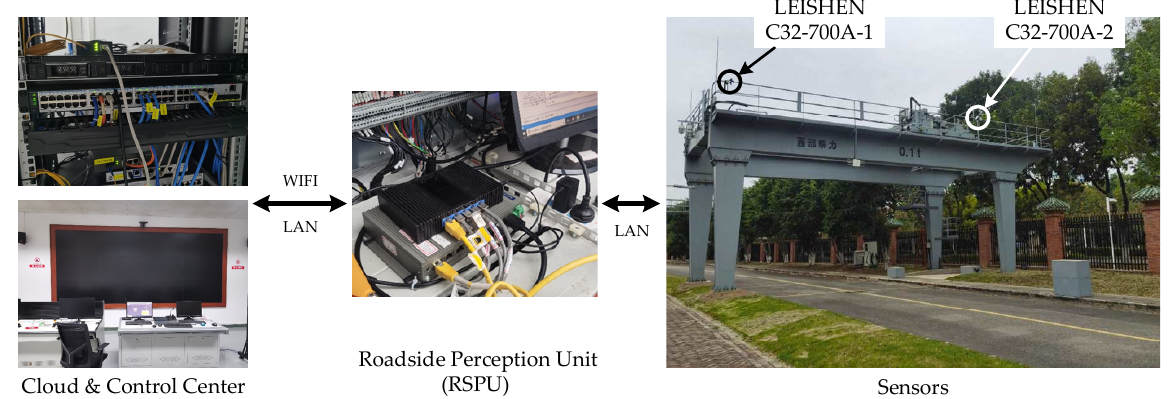
Figure 16. The roadside Lidar measurement system.